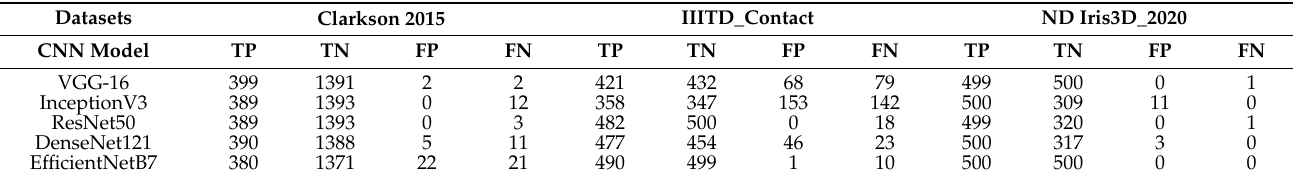
Table 9. Confusion matrix of all pre-trained models across all datasets.